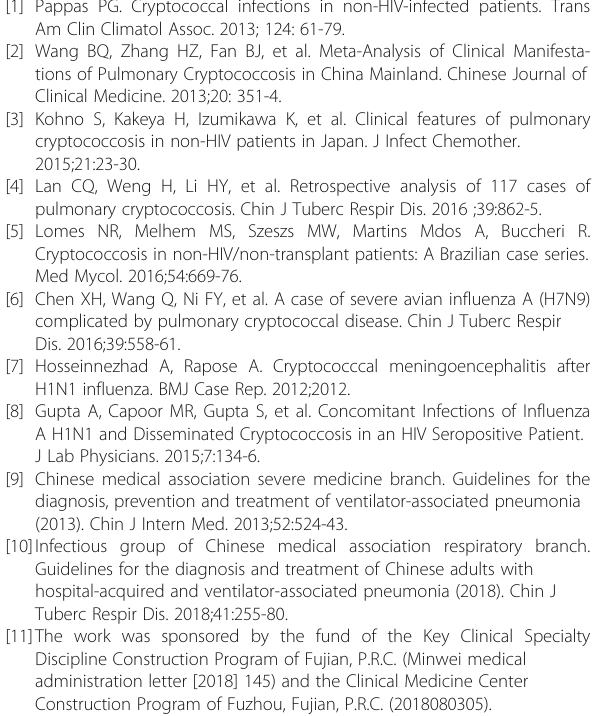
(Table 1). Patients on VAD (OR: 8.7, IC95%: 1.1-71.1, p=0.043) or RRT (OR: 3.6, IC95%: 1.1-71.1, p=0.043) had a higher risk for CMV viremia, while use of MV (OR: 1.1, IC95%: 0.2-5.9, p=0.925) or HFNC (OR: 0.5, IC95%: 0.2-1.6, p=0.246) was not related. CMV viremia was not associ- ated to ICU (OR: 1.4, IC95%: 0.45-5, p=0.594) or hospital mortality (OR: 1.4, IC95%: 0.5-5, p=0.464), length of mechanical ventilation (OR: 0.9 IC95%: 1-1, p=0.942), length of ICU (OR: 1.0, IC95%: 1-1, p=0.875) or hospital admission (OR: 1, IC95%: 1-1, p=0.837).